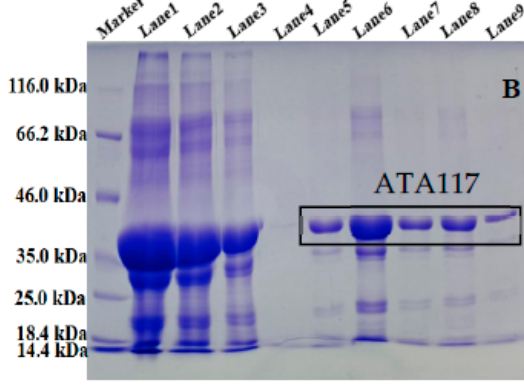
5 of 18 Table 2. Induced expression of the constructed recombinant plasmids. Enzyme Expression Form Original Plasmid